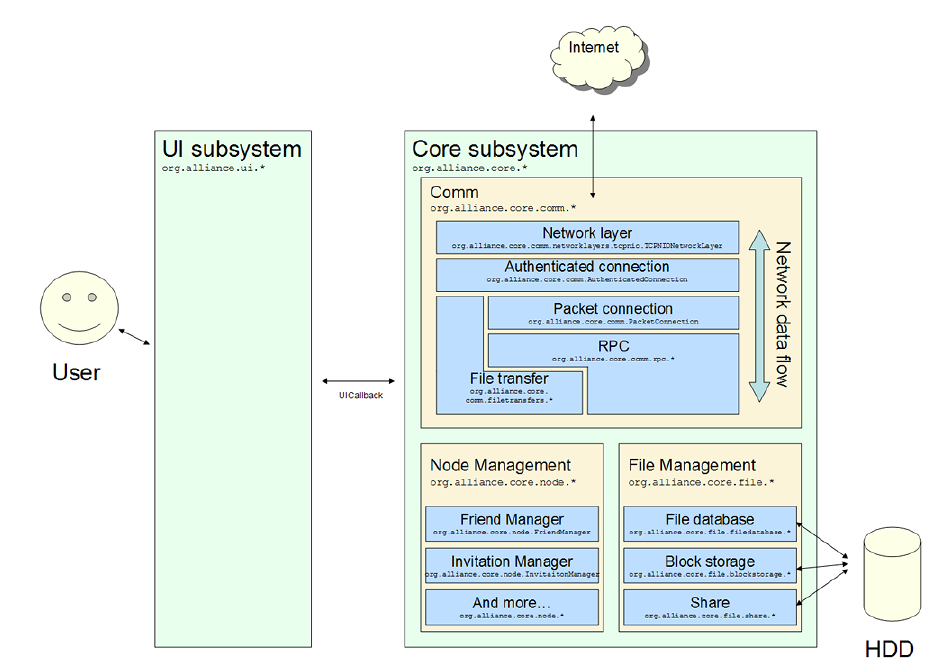
Figure 5. Alliance P2P architecture